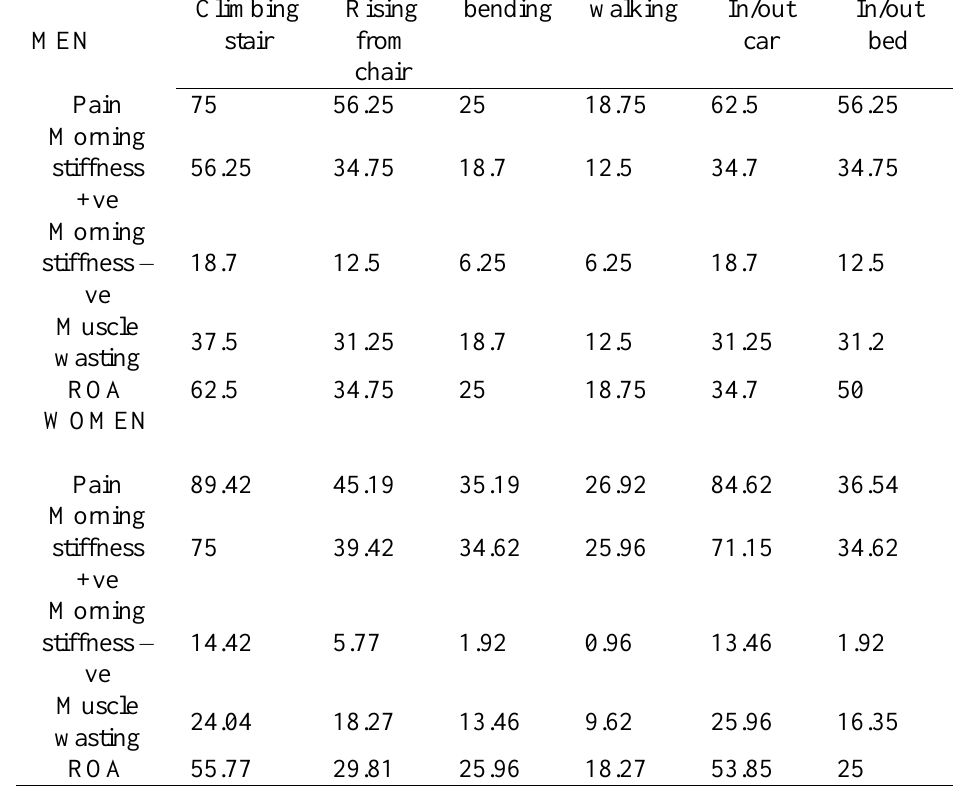
Table 4: Prevalence (%) of disability in the six separate functions, which constitute the locomotor disability index, in men and women according to joint